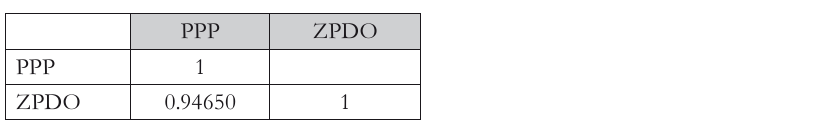
Tab. 6 – Correlation matrix of variables in the model of problems with payment discipline.